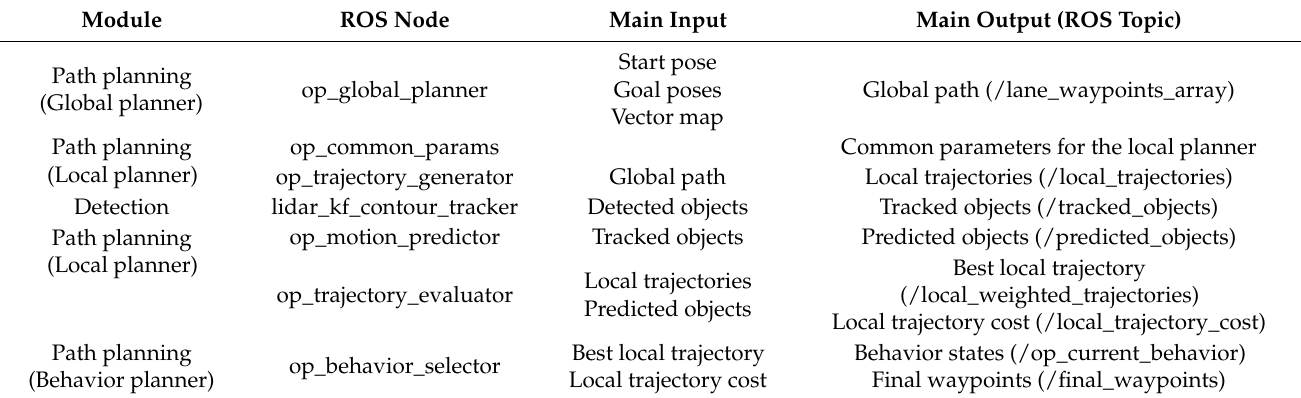
Table 14. List of ROS nodes comprising OpenPlanner and their main inputs and